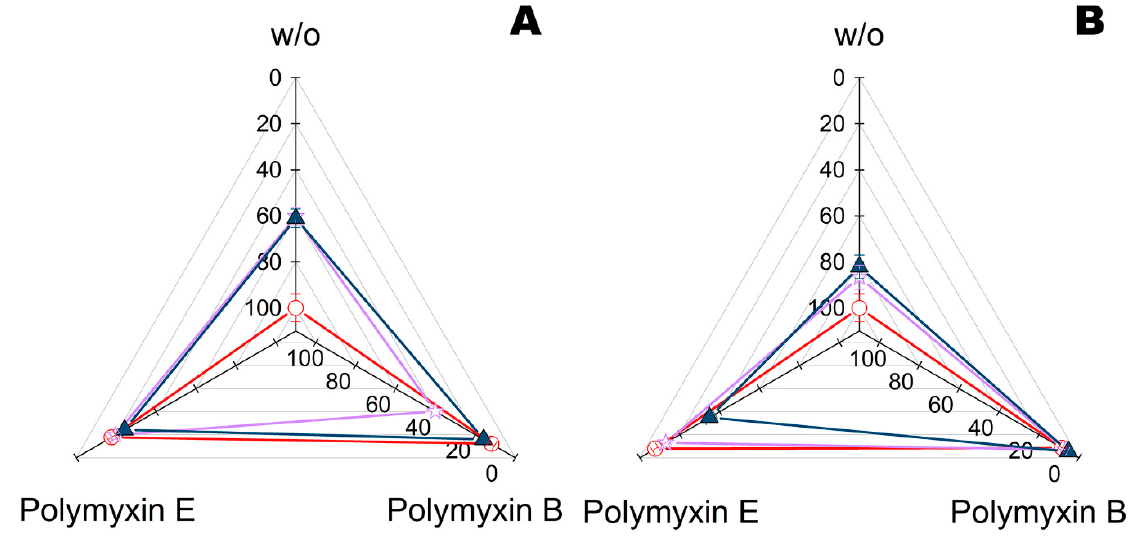
Figure 2. Affinity ( A ) of PLE 50 , PLD 50 , PEG-PLE 50 , PEG-PLD 50 , PLE 50 -PEG-PLE 50 and succinylated gelatin (gelofusine), and the relative area ( B ) which they occupy on the surface of PvdQ ( ○ ) or His 6 -OPH ( ● ) at pH 7.5. Designations: mean value ( ■ ), 1st and 99th percentile (×); interquartile ranges are bordered, median values are presented by horizontal lines, and data points are aligned to the left. The diameters of bubbles in ( B ) are proportional to the values of occupied areas with a scaling factor of 6 for illustration purpose. Data for His 6 -OPH correspond topreviously obtained [20].